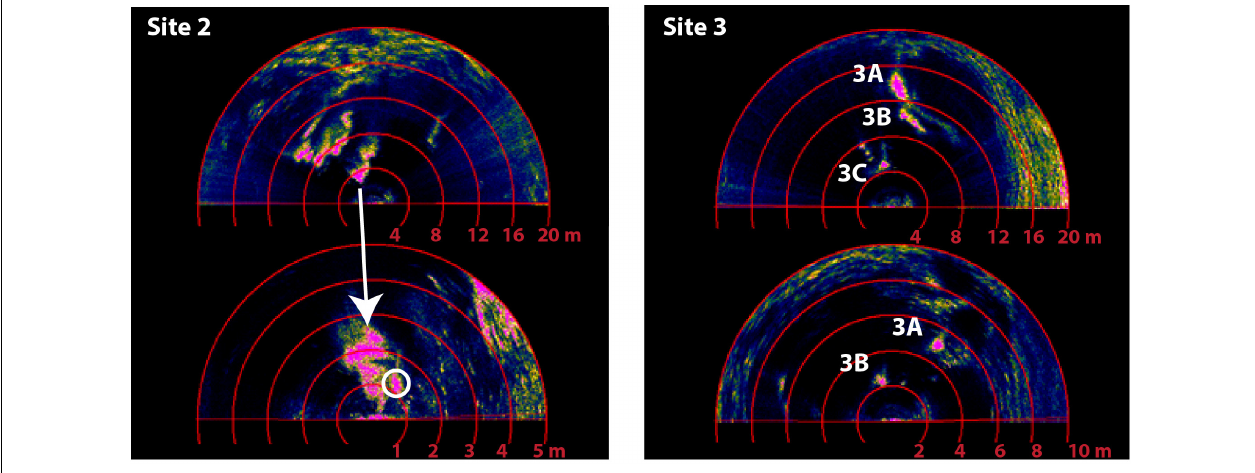
FIGURE 7 | Screenshots of the echograms from the ROV-based forward-looking sonar showing anomalies from bubble streams at Site 2 and Site 3. The signal at Site 2 is composed of several (in total ∼ 17) hydro-acoustic anomalies representing bubble streams, of which one bubble stream was quantified (white circle). At Site 3, three major hydro-acoustic anomalies were recorded. Two bubble streams generating anomaly 3C were quantified, corresponding to about one-third of the total bubble flow in this area.